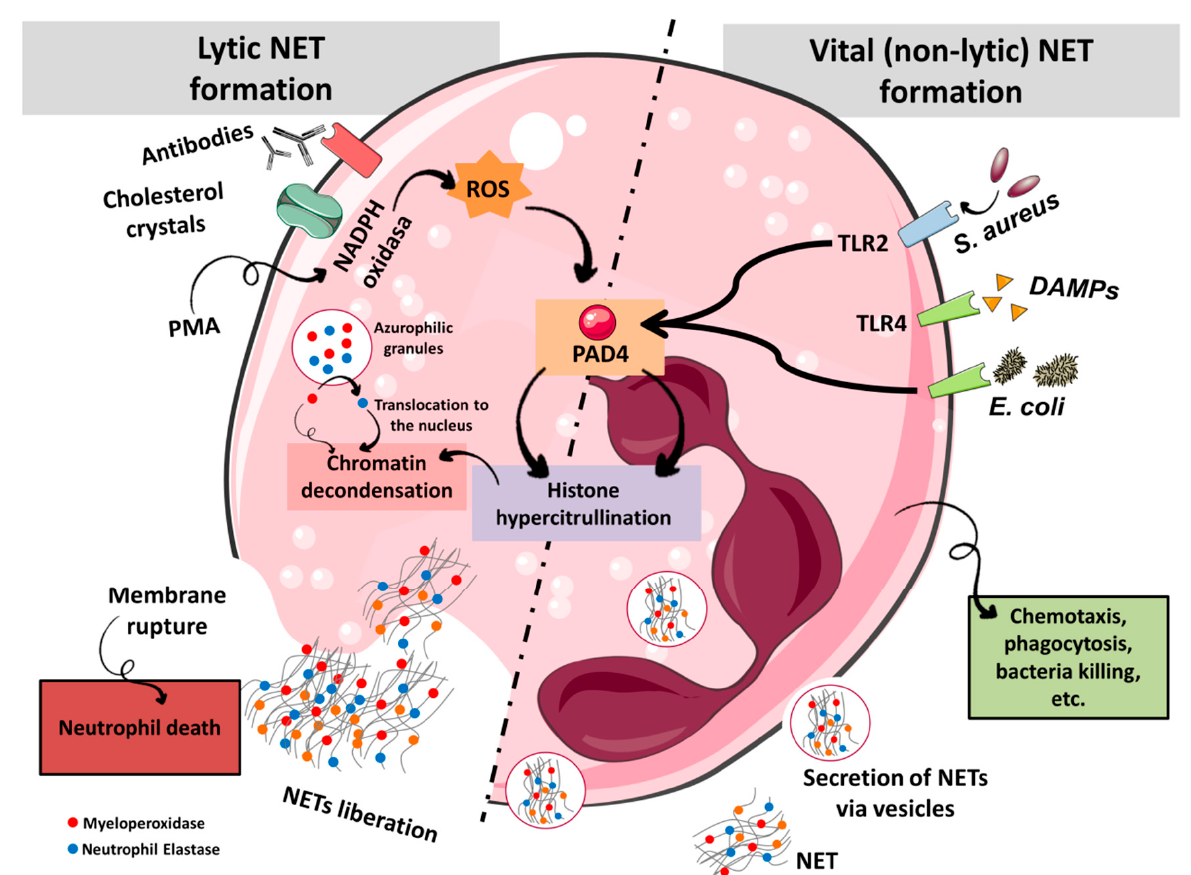
Figure 1. NET formation mechanisms. In response to effectors such as PMA, cholesterol crystals or antibodies, neutrophils perform lytic NETosis. Activation of NADPH oxidase produces ROS that activate PAD4 allowing chromatin decondensation. Concomitantly, neutrophil elastase (NE) and myeloperoxidase (MPO) are translocated into the nucleus and degrade histones, provoking an additional chromatin decondensation. DNA is released into the cytosol and then to the external milieu together with granular and cytosolic proteins inducing neutrophil death. Alternatively, the interaction of neutrophils with bacteria or platelets through TLRs provokes a process called vital NET formation. This mechanism also activates PAD4 and translocation of NE and MPO into the nucleus. Importantly, this process does not provoke the neutrophil death since DNA is secreted via vesicles and instead the cell conserves certain physiological capacities such as phagocytosis.